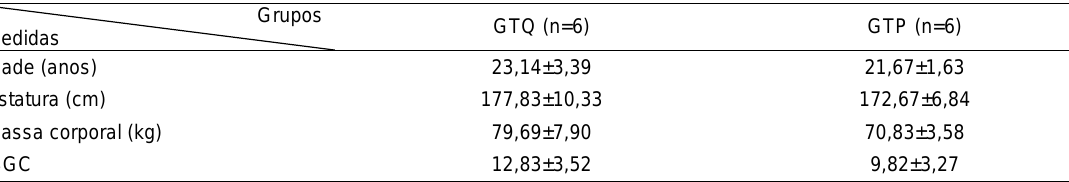
Tabela 1. Caracterização dos sujeitos quanto à média e desvio padrão da idade, da estatura, da massa corporal e do percentual de gordura corporal